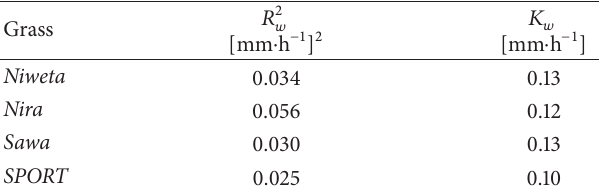
Table 2: Measures of good fit of the model.